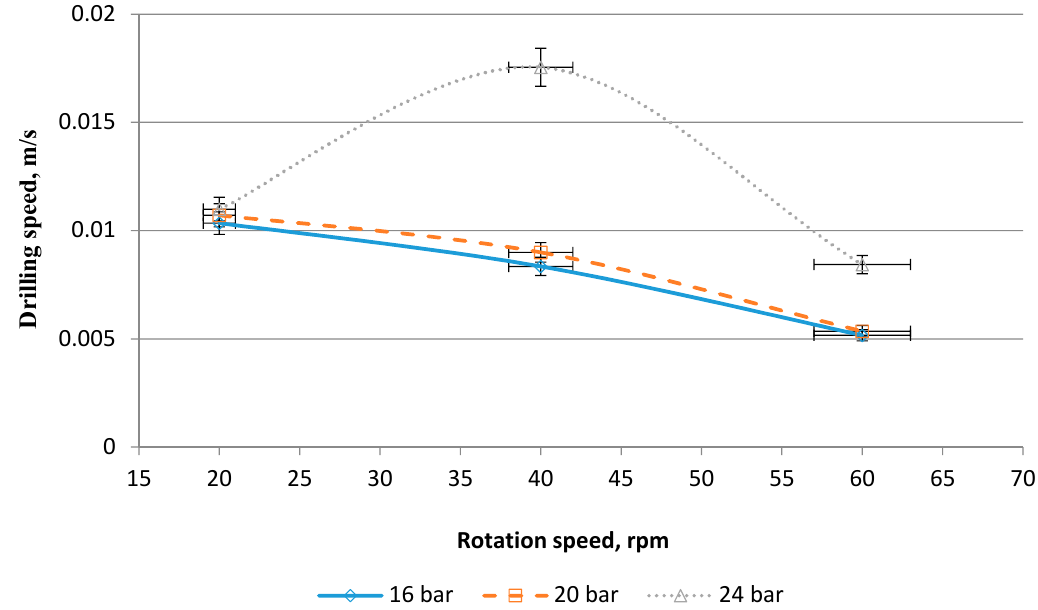
Figure 8. Variation of drilling velocity with rotation speed for several pressures (shown in the legend below the figure), for the 127 mm diameter drill bit, an interval of 54 to 72 m below the ground level, and boreholes 4–6.